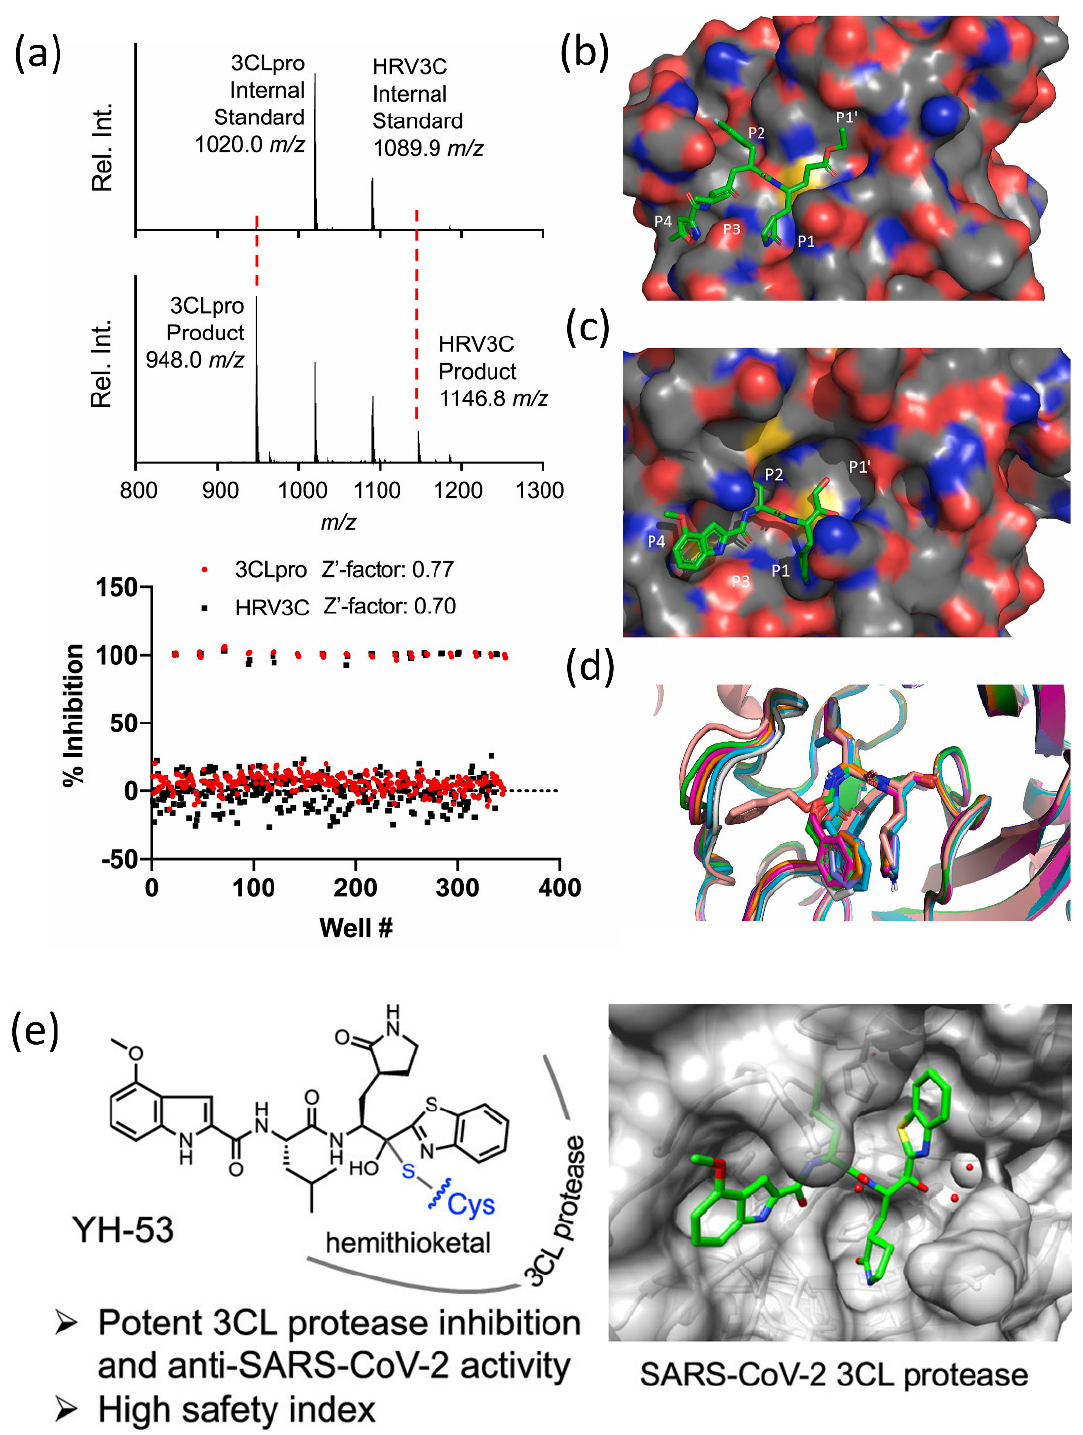
Figure 3. ( a ) SAMDI-MS spectra of duplexed reactions before and after 3CLpro and HRV3C activity (top and bottom). ( b – d ) Structural analysis of protease inhibitor binding sites. Rupintrivir binding mode in HRV3C protease ( b , c ). ( d ) Superimposition of previously reported SARS-CoV-2 3CL-pro structures with bound GC376. Reprinted with permission from [60]. Copyright 2021, Elsevier. ( e ) The most powerful and effective inhibitor, YH-53, can effectively prevent SARS-CoV-2 replication. Reprinted with permission from [59]. Copyright 2022, American Chemical Society.